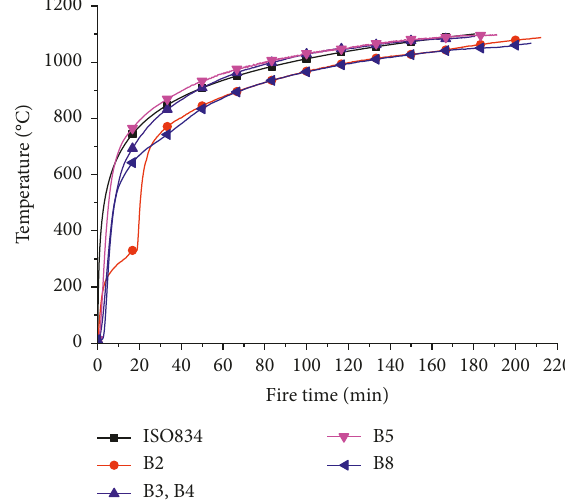
Figure 5: Measured time-temperature curve in the furnace.